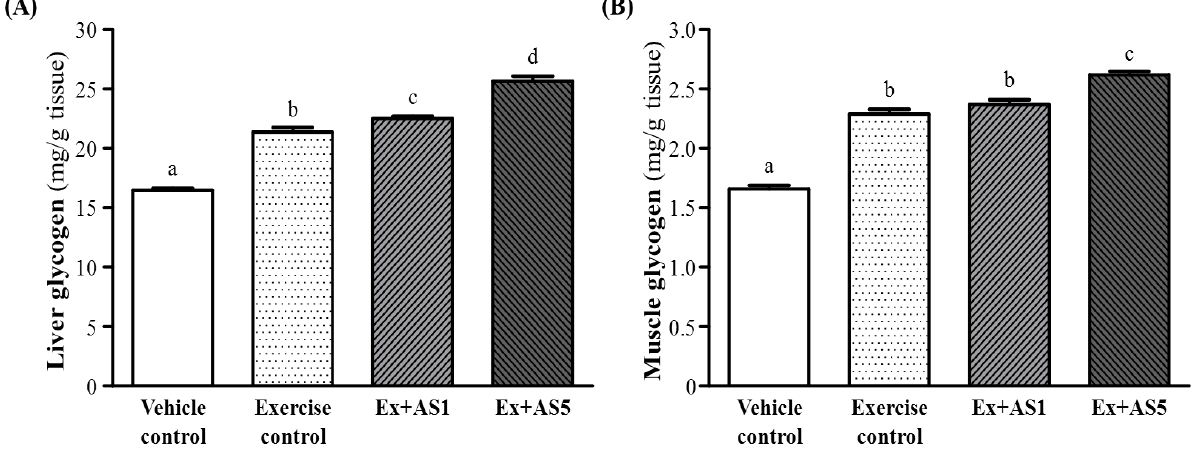
Figure 4. Effect of AS supplementation on hepatic glycogen ( A ) and muscle glycogen ( B ) level. Data are mean ± SEM of 10 mice in each group by one-way ANOVA. Different letters (a, b, c and d) indicate significant difference at p <